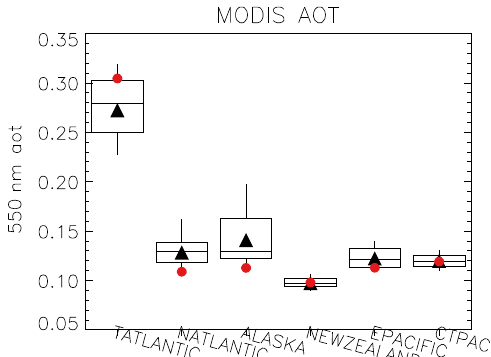
Figure 11. As in Fig. 9 but for the August MODIS 550nm AOT. Only values over oceans are included in the regional